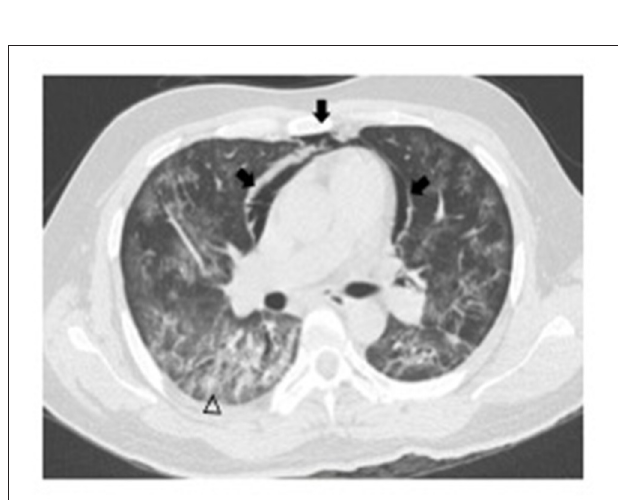
FIGURE 2 | A 43-year-old male non-enhanced chest CT image showing pneumomediastinum (arrows) and ground glass opacity pattern over peripheral subpleural areas (arrowhead).